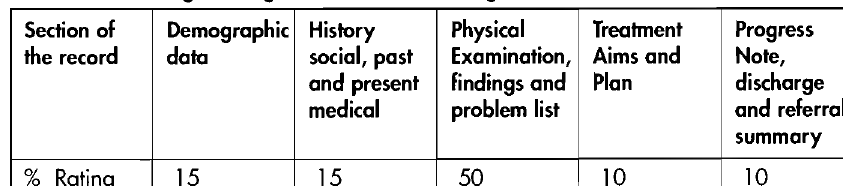
Table 1: Percentage Ratings of the QA Measuring